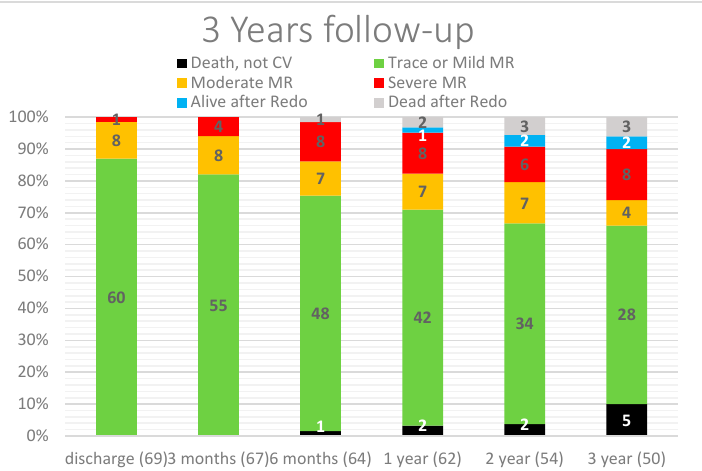
Figure 1. Outcomes at 3-year follow-up. CV: cardiovascular; MR: mitral regurgitation.